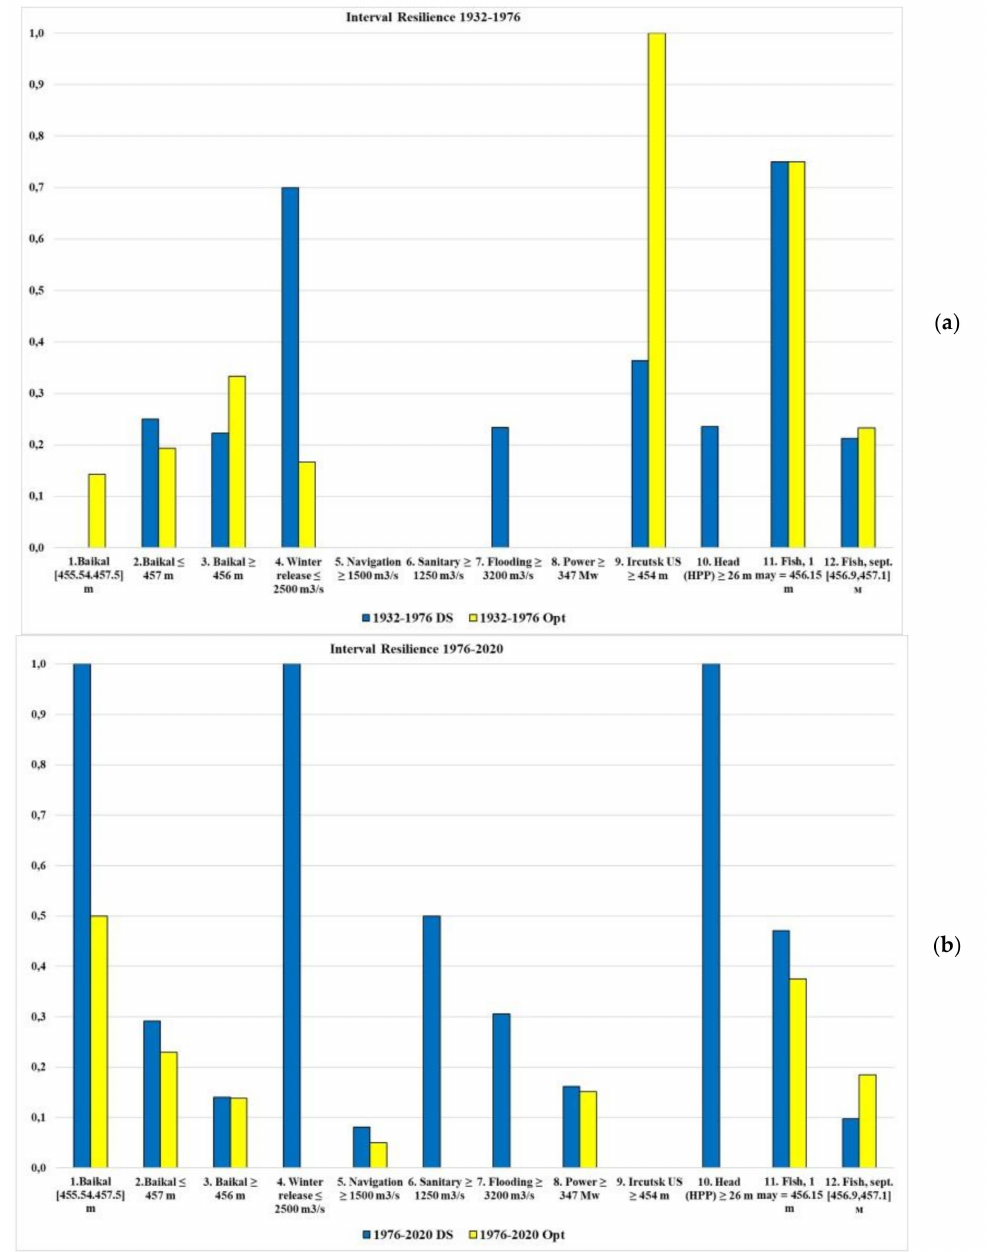
Figure 18. Interval resilience indicators when WRC use DS and optimization ( a ) series 1932–1976 ( b )